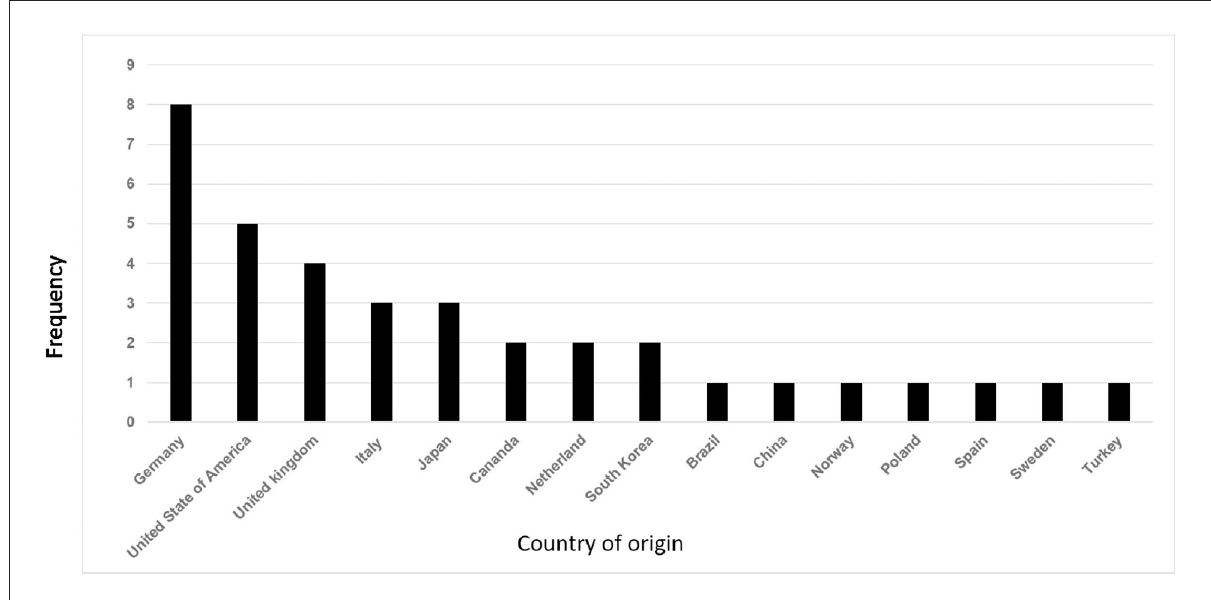
FIGURE2 Distribution of included studies by country of origin.